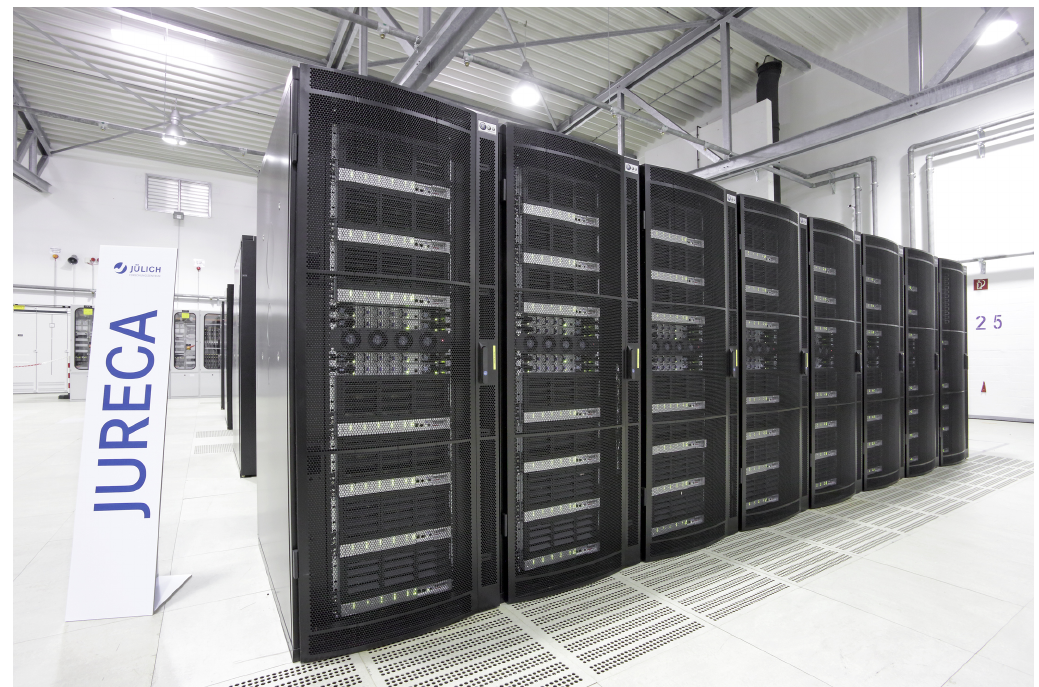
Figure 1: Jülich Research on Exascale Cluster Architectures (JURECA) at Jülich Supercomputing Centre. Copyright: Forschungszentrum